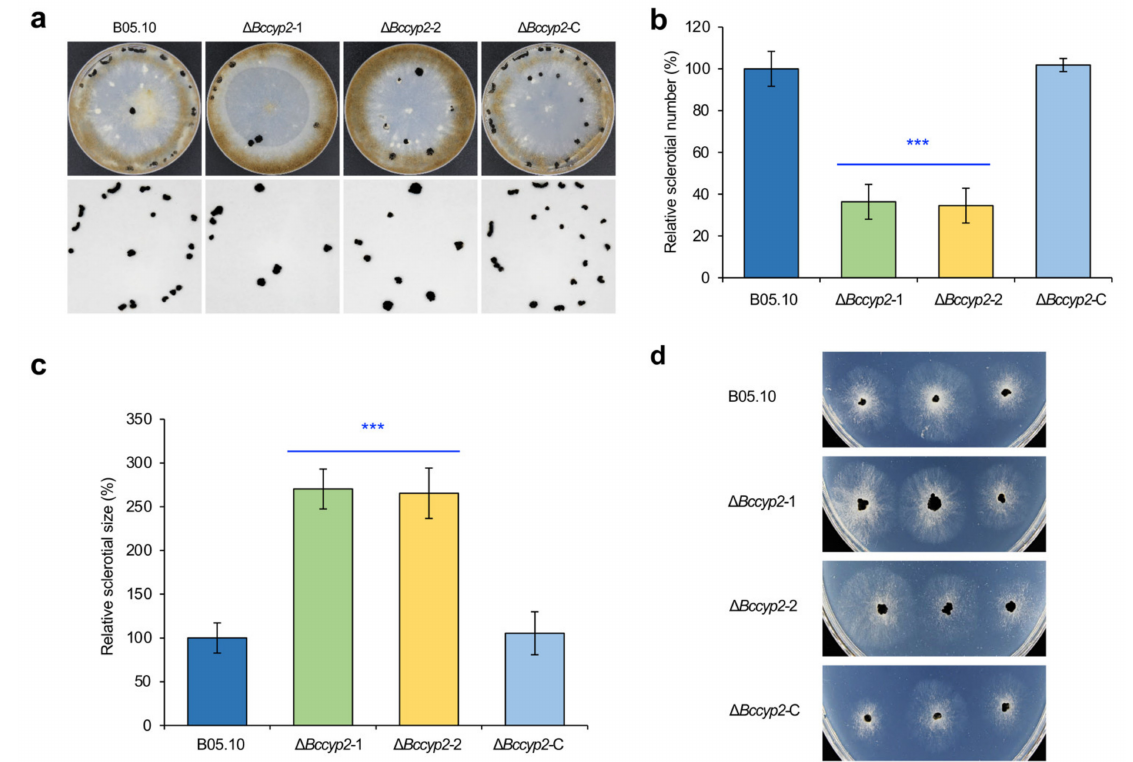
Figure 2. BcCYP2 mediates B. cinerea sclerotium production and morphogenesis. ( a ) Deletion of BcCYP2 in B.cinerea reduces sclerotium production. Conidia of the wild-type (WT), ∆ Bccyp2 , and complemented strains were inoculated on CM plates and cultured at 20 ◦ C in the dark. Sclerotium production was photographically documented at four weeks post-incubation. ( b ) Quantification of sclerotium production. ( c ) Quantitative analysis of sclerotial sizes of the indicated strains via ImageJ software (https://imagej.nih.gov/ij/download.html (accessed on 1 January 2021)). ( d ) Germination of sclerotia produced by the tested strains. The representative images are from one of the experiments, at least three independent experiments were performed, and all the experiments resulted in similar results. Data represent means ± SD from at least three independent experiments. ***: significance at p <